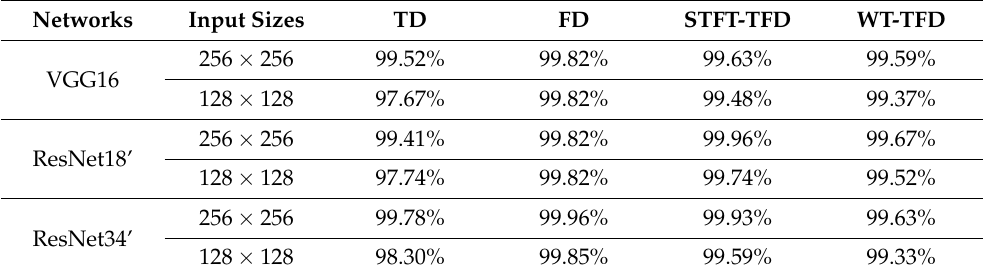
Table 7. Test accuracies of